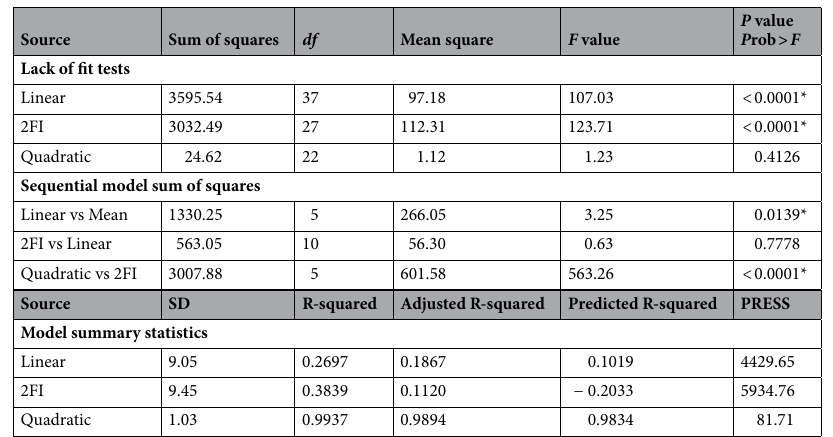
Table 5. Fit summary for FCCCD for biosorption of Hg 2+ by Gelidium corneum biomass results. df degree of freedom, PRESS sum of squares of prediction error, 2FI two factors interaction. *Significant